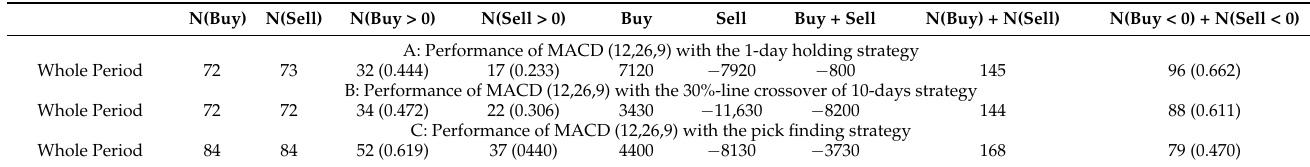
Table 6. The Performance of the Traditional MACD (12,26,9) Model with the Three Strategies. N(Buy) N(Sell) N(Buy >